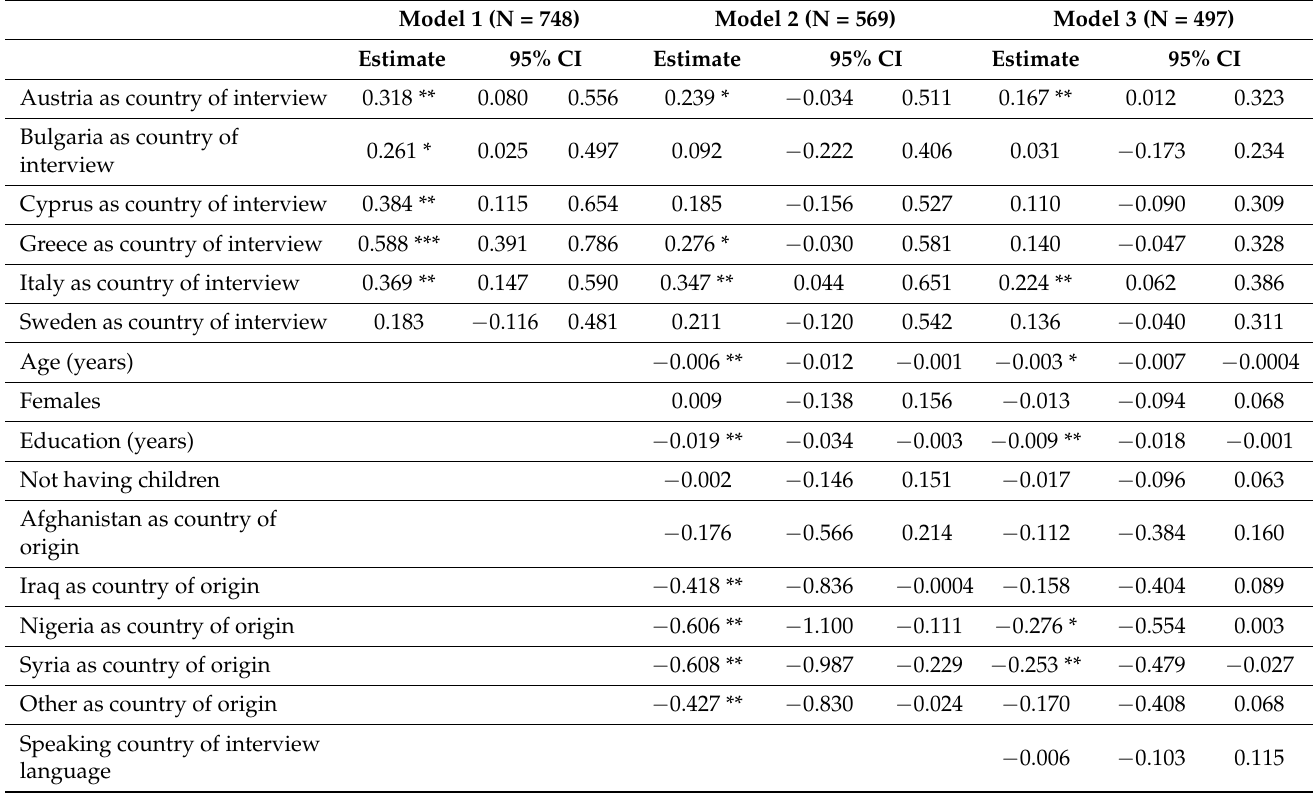
Table 5. Multivariable linear regression models investigating the impact of country of interview, country of origin, and socioeconomic characteristics on Discrimination Scale to Medical Settings (dependent variable) in migrants and refugees. Migrants and refugees from Germany, France, and Malta were excluded from the